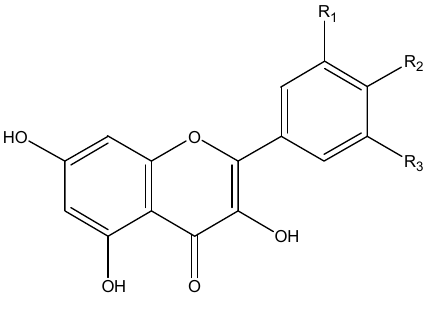
Figure 6. The chemical structures of quercetin (R 1 = H, R 2 = R 3 = OH), kaempferol (R 1 = R 3 = H, R 2 = OH), myricetin (R 1 = R 2 = R 3 = OH), galangin (R 1 = R 2 = R 3 = H) and isorhamnetin (R 1 = H, R 2 = OH, R 3 = OCH3).